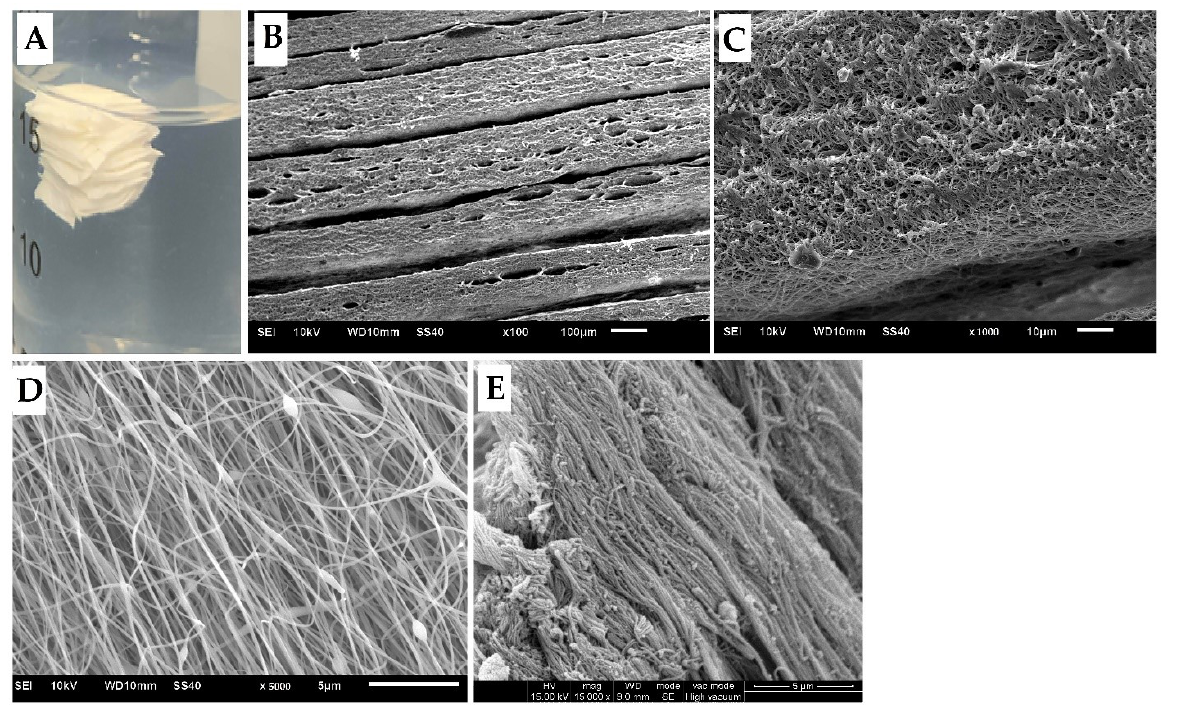
Figure 1. 1 Figure 2. The appearance and SEM images. ( A ) The gross appearance of multilayer electrospun implant. ( B ) SEM image of multilayer electrospun implant from the side, 100 × . ( C ) SEM image of multilayer electrospun implant from the side, 1000 × . ( D ) SEM image of electrospun membrane from the top, 5000 × . Average fiber diameter is 245.3 ± 50.7 nm ( n = 100). ( E ) SEM image of native AF tissue, 5000 × . Average fiber diameter is 162.9 ± 38.8 nm ( n = 100).